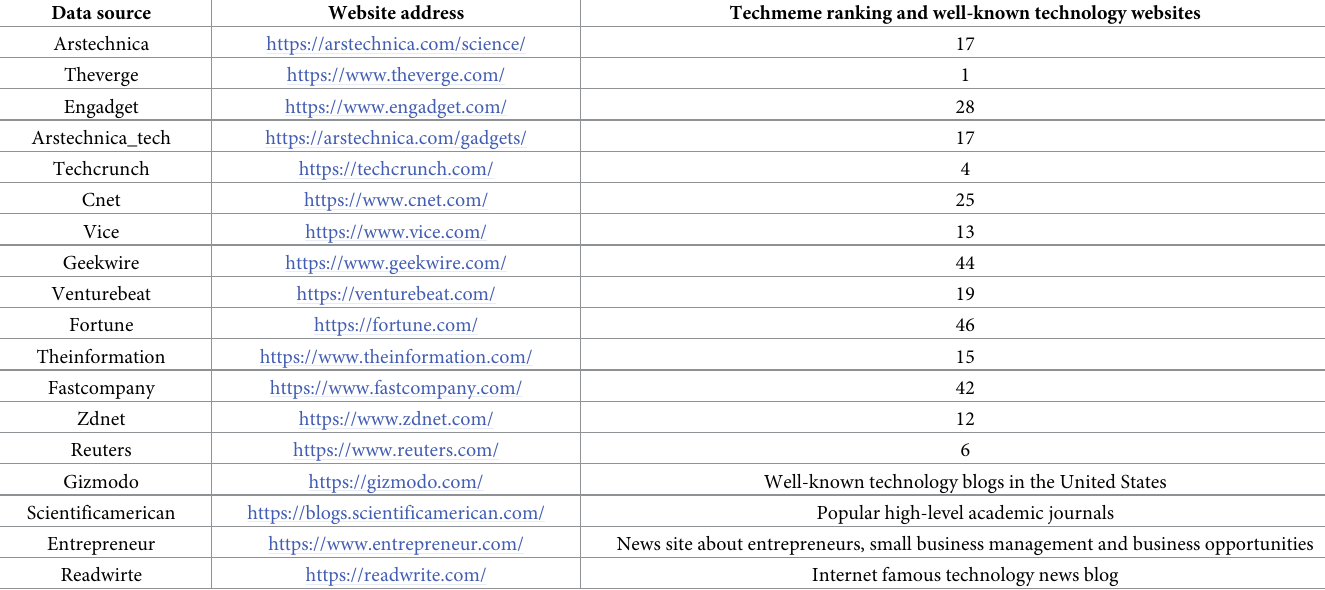
Table 1. Ranking of technology